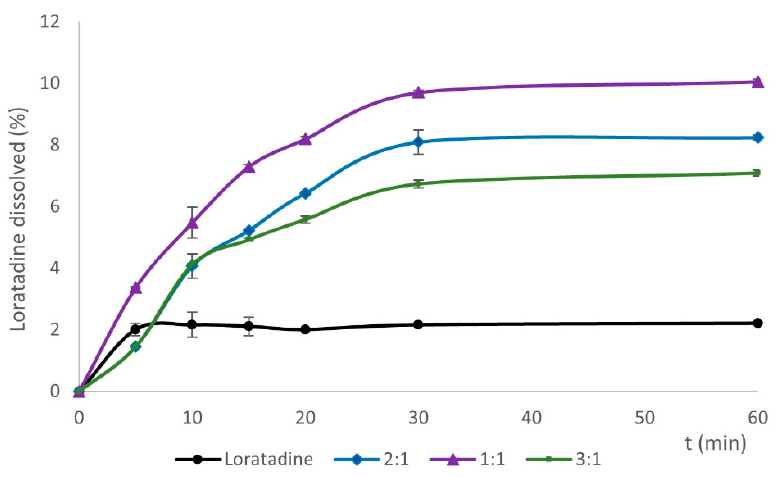
Figure 4. Dissolution curves of loratadine and binary mixtures 1:1, 2:1, 3:1 of loratadine–citric acid in water.